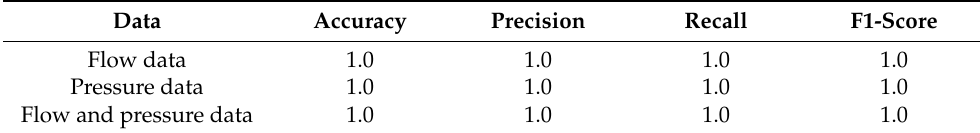
Figure 13. Application of the ANN method with the water supply data. Table 9. Results obtained with the